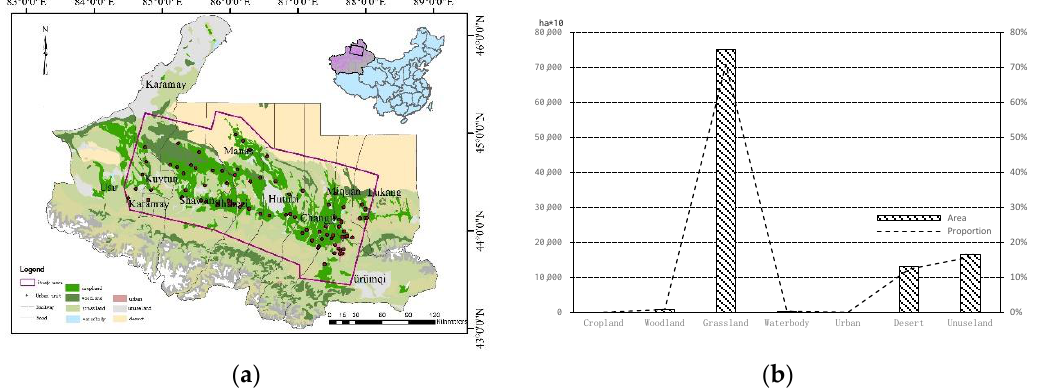
Figure 1. ( a ) The location of the North Xinjiang Economic Zone (NXEZ); ( b ) area ratio of di ff erent Figure 1. ( a )The location of the North Xinjiang Economic Zone (NXEZ); ( b ) area ratio of different land land types.